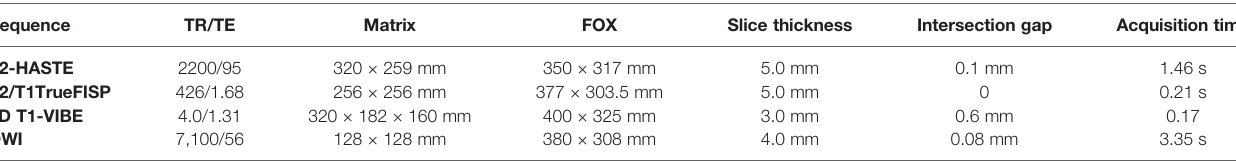
TABLE 1 | Sequence parameters for MRI pancreatic protocol.